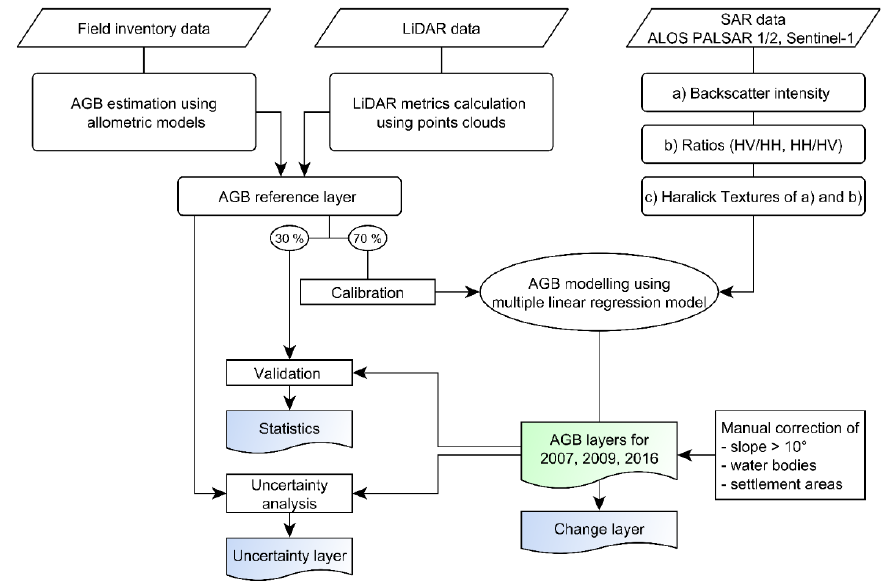
Figure 2. Flow chart of the AGB map processing steps. Blue refers to the results, and green refers to the main